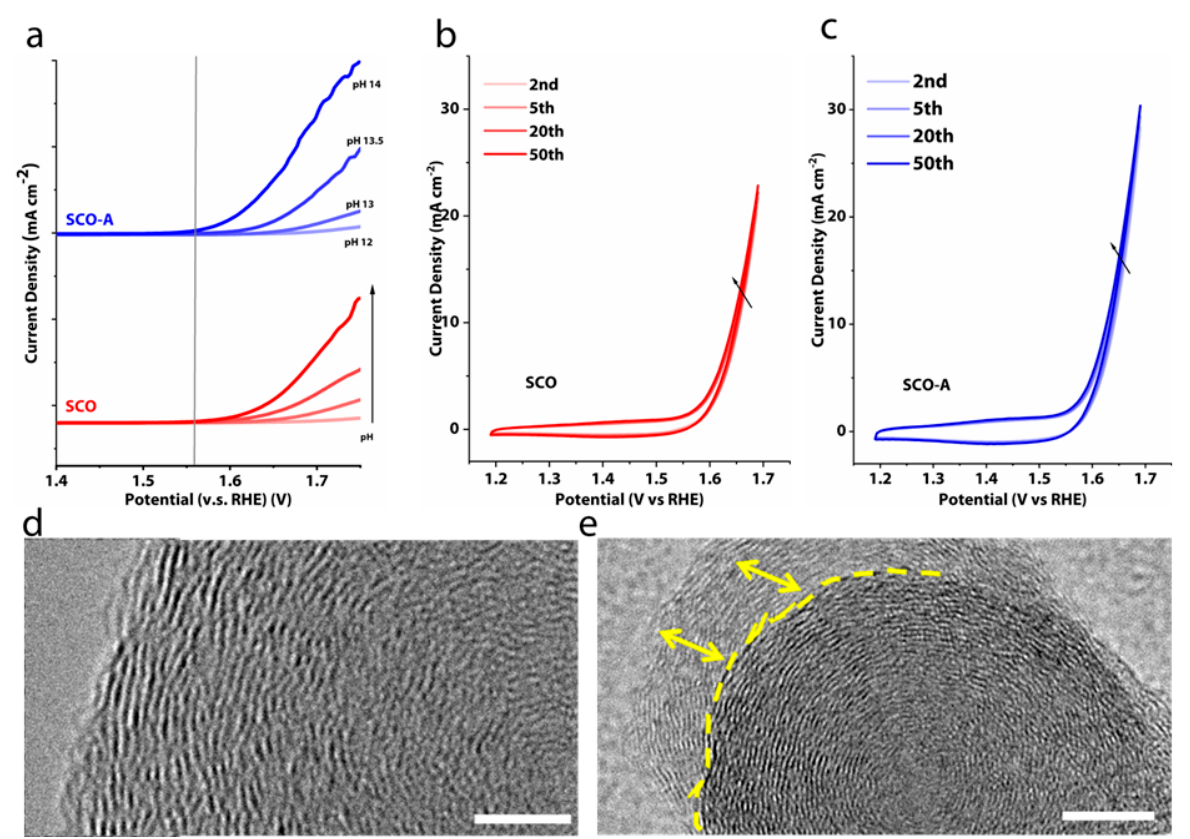
Figure 3. The oxygen evolution mechanism studies for SCO and SCO-A. ( a ) OER kinetics of SCO and SCO-A in O 2 -saturated 1M KOH environment with varying pH. CV curves of ( b ) SCO. ( c ) SCO-A. TEM images after 50 th cycles: ( d ) SCO. ( e ) SCO-A (scale bar 2 nm).